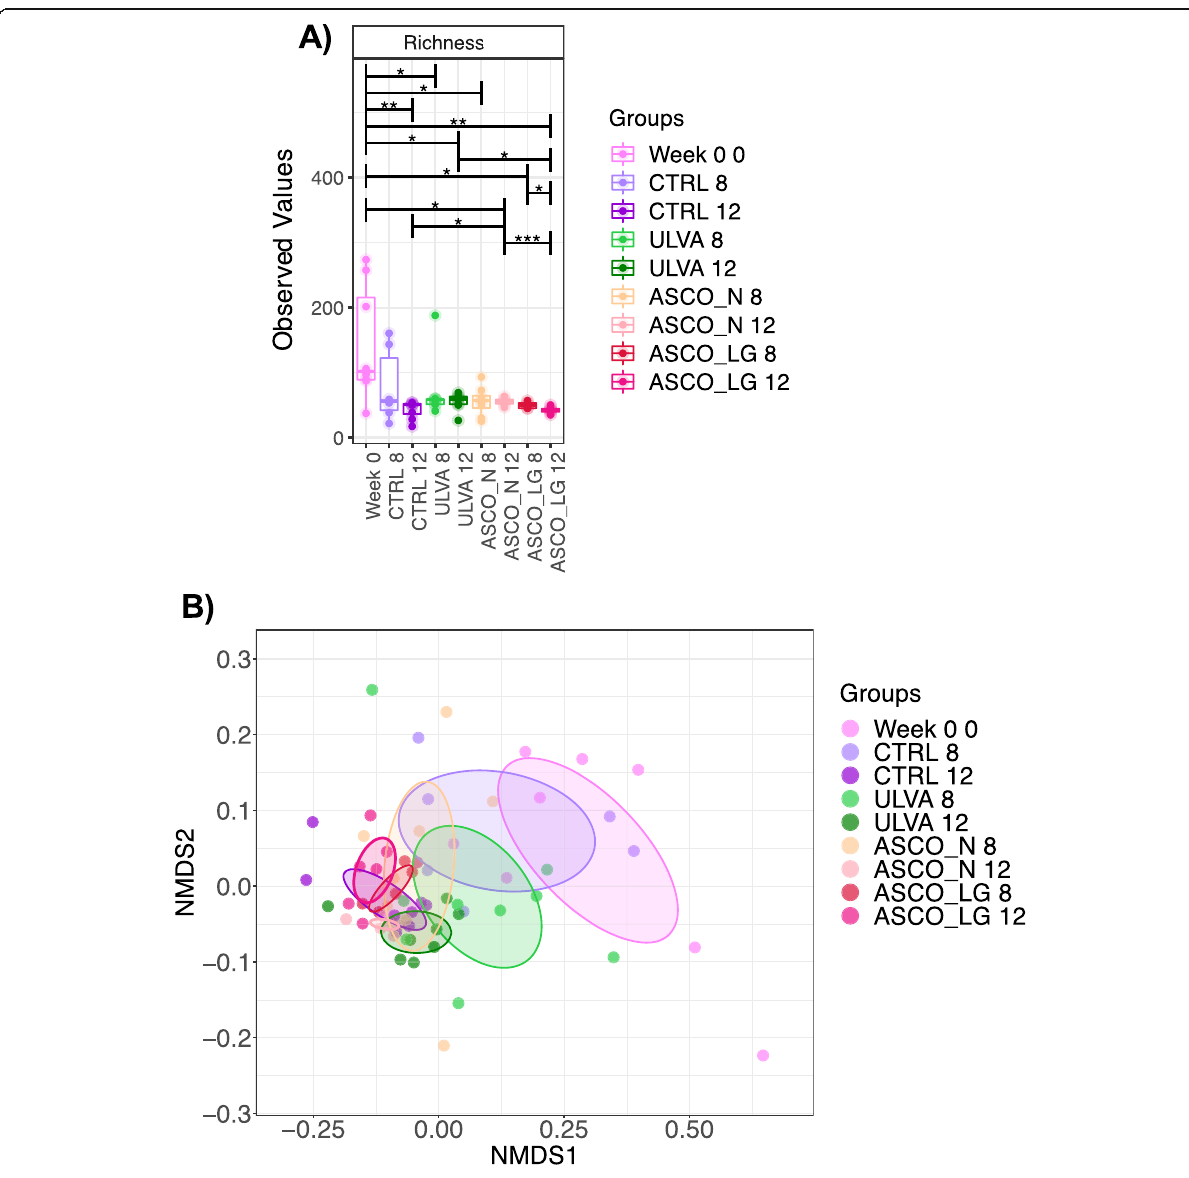
Fig. 3 a Alpha diversity measure: Species Richness with the corresponding colour legend for the treatment groups. Pair-wise ANOVA P -values are displayed P < 0.05*, P < 0.01**, P < 0.001***. b Non-metric distance scaling (NMDS) plot based on Unifrac phylogenetic distance with colour coded circles representing the differing treatment groups over time (R2 = 0.27182, P =